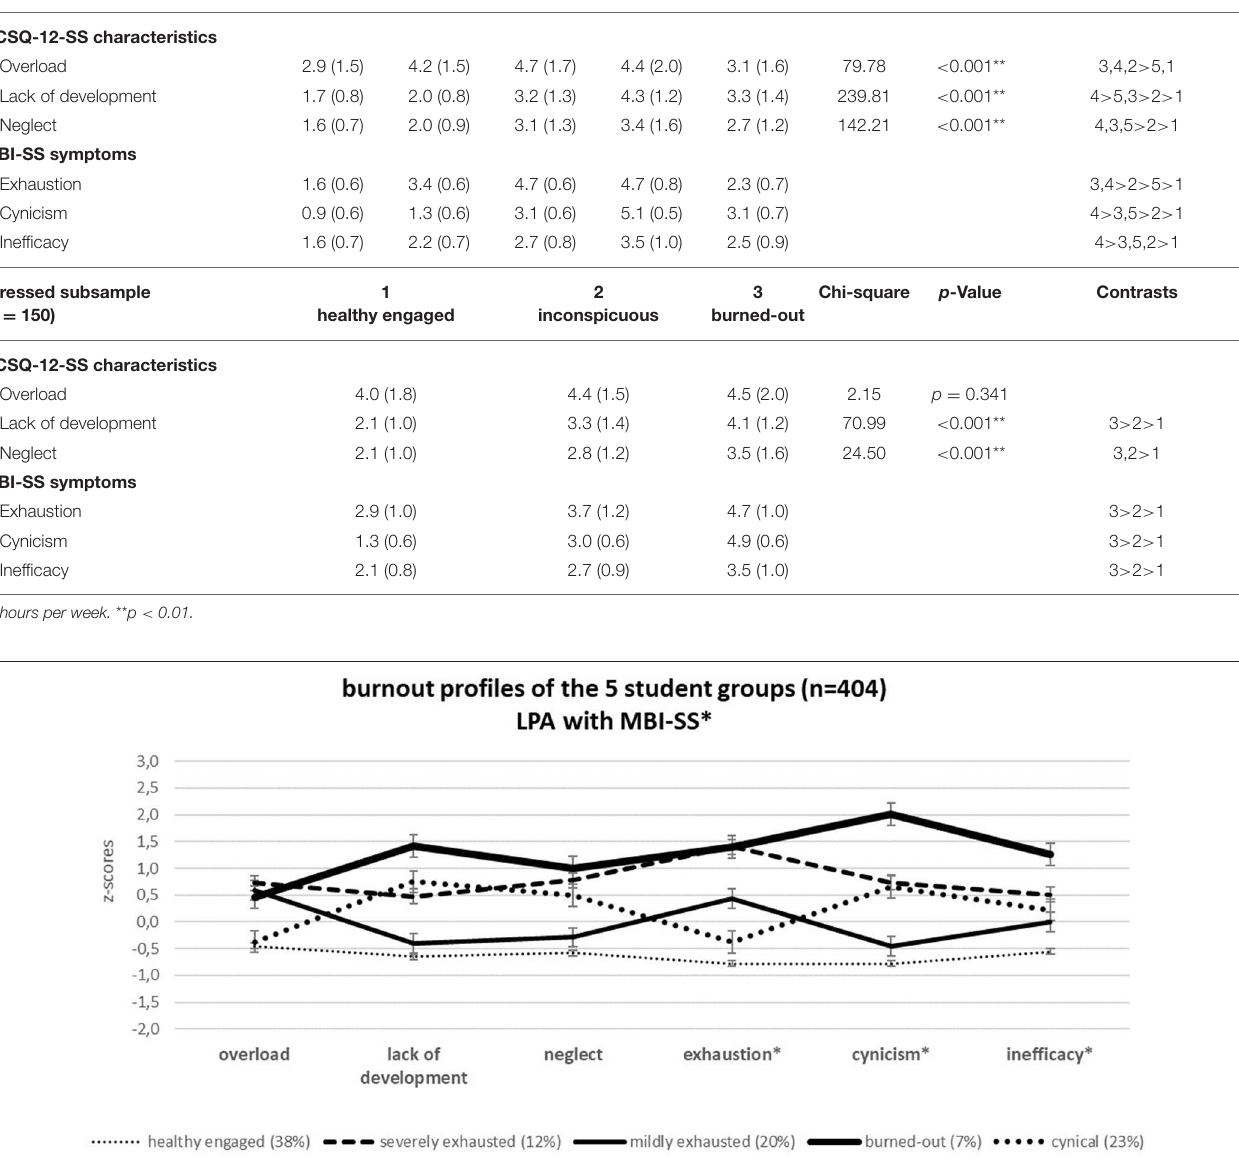
TABLE 8 | Burnout characteristics of the five MBI-SS classes in the entire sample and in the stressed subsample. Entire sample ( n = 404)